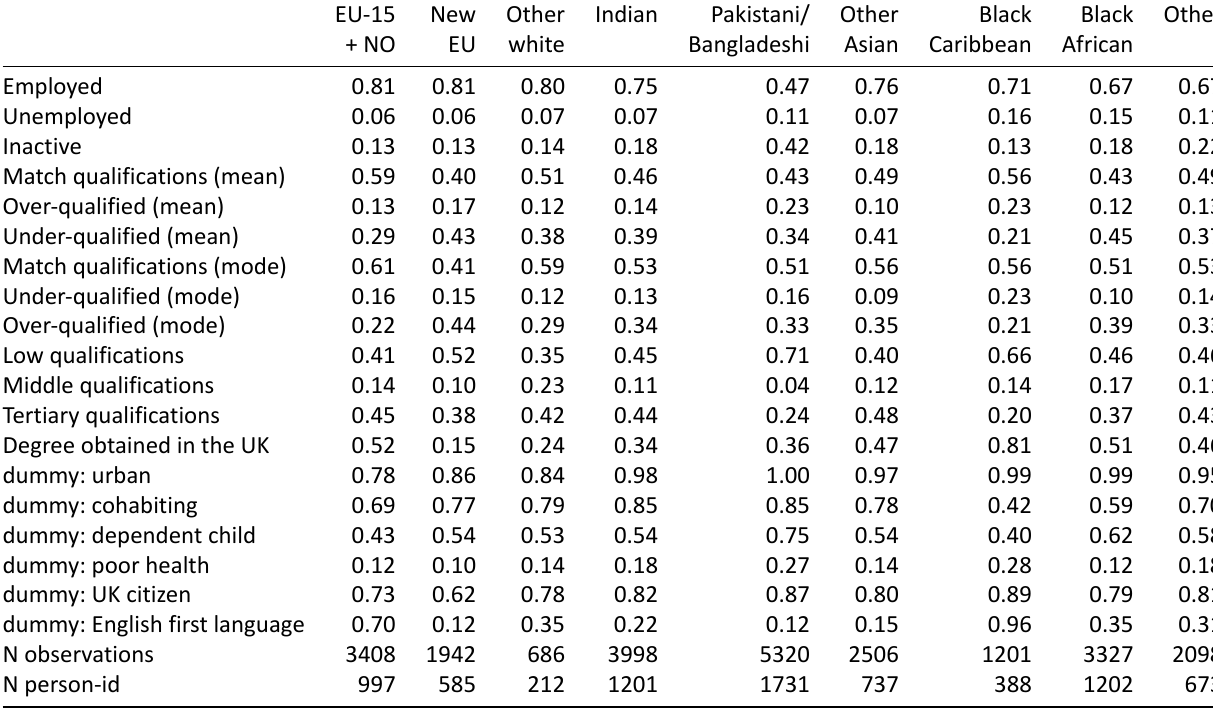
Table A1b. Descriptive statistics of sample for